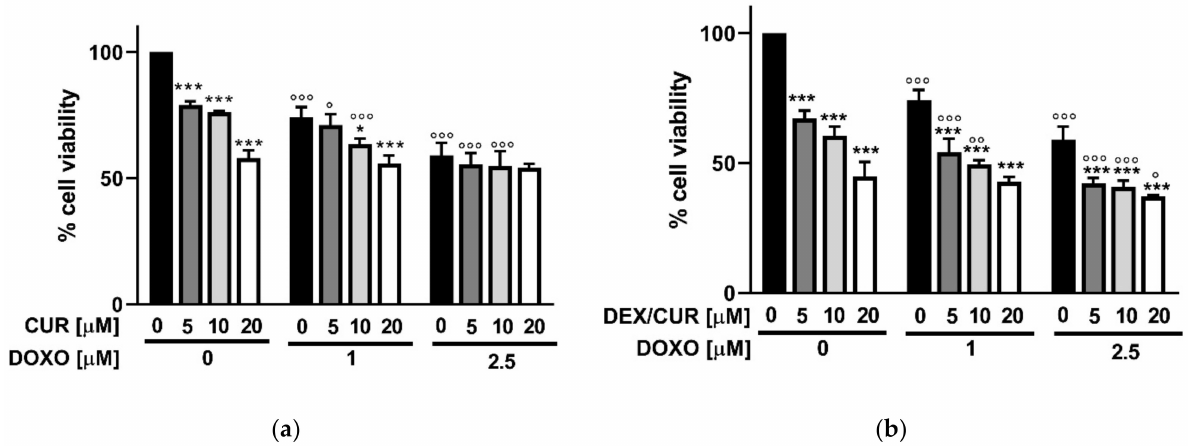
Figure 10. Cell viability assay on PC-3 cells treated for 48 h with a combination of DOXO and ( a ) CUR and ( b ) DEX/CUR at different concentrations. Data were reported as mean values ± SD of three independent experiments. Two-way ANOVA followed by Dunnett’s method: * p <0.05, and *** p < 0.0001, compared to DOXO single treatments. ◦ p < 0.01, ◦◦ p < 0.001, ◦◦◦ p < 0.0001 vs. CUR or DEX/CUR single